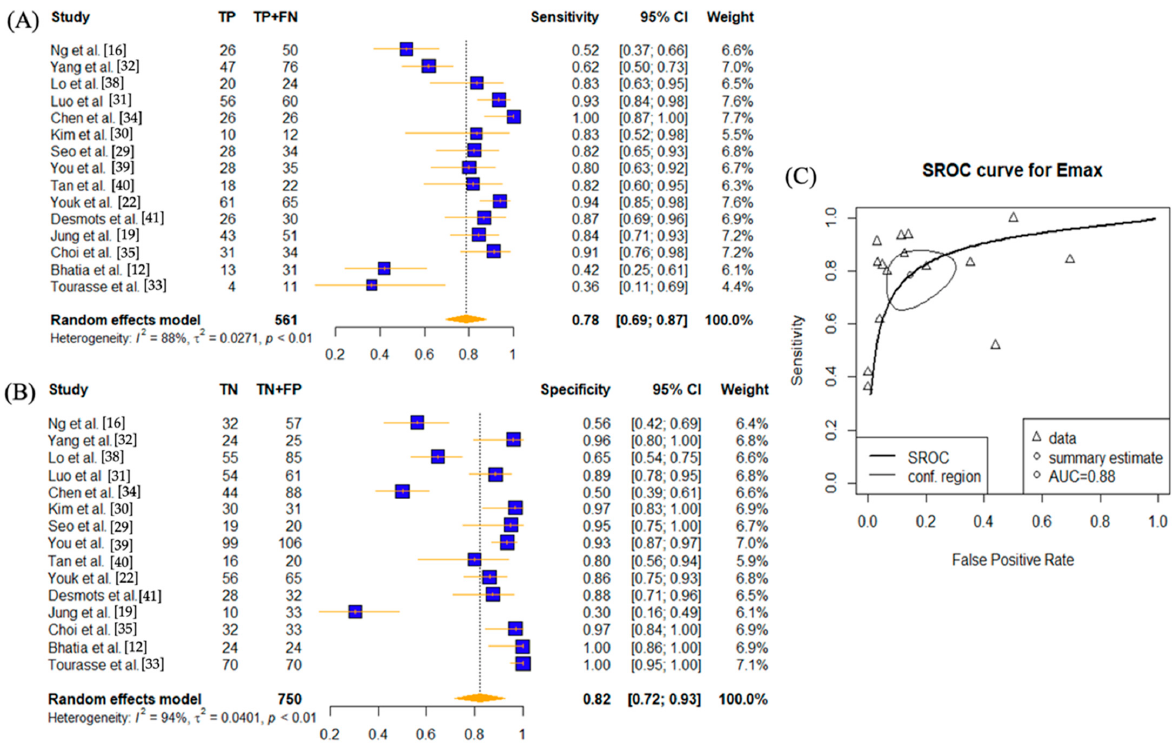
Figure 2. Sensitivity and specificity forest plots and overall accuracy results of E max . ( A – C ) Reported sensitivity and specificity values for E max values per selected study with AUC value on SROC curve for analysis of E max . Forest plots for pooled sensitivities and specificities are displayed as diamonds in the graphs for E max ( A , B ). The SROC curve indicates the summary estimates in circles (( C ) for E max ). Triangles represent included study with dotted lines representing the confidence interval and solid line for the SROC. AUC value is displayed (in the legend). E max —maximum tissue stiffness SWE parameter; AUC—area under the curve; SROC—summary receiver operating characteristic.